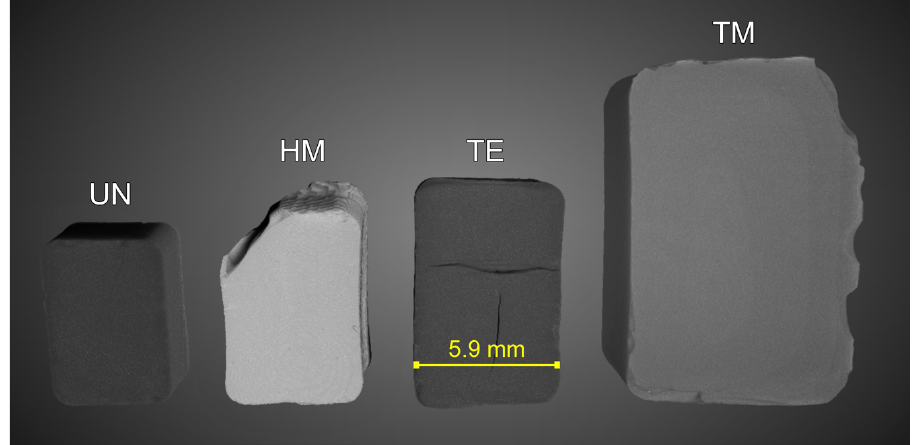
Figure 6. The samples as they appear in the Dragonfly software after segmentation. From left to right, the unmodified UN, hexamethyldisilazane-modified HM, triethylchlorosilane-modified TE, and trimethylchlorosilane-modified TM samples are shown. One dataset from each surface modification batch was selected. Additionally, a scale bar was added for the TE sample for